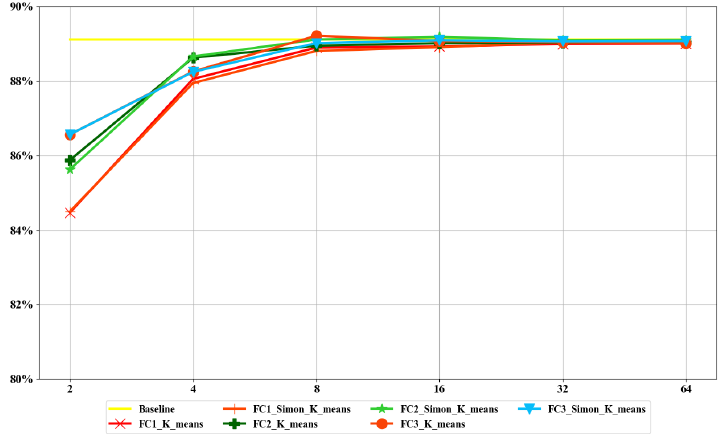
Figure 7. Accuracy of LeNet-5 for each fully connected layer with different values of k .